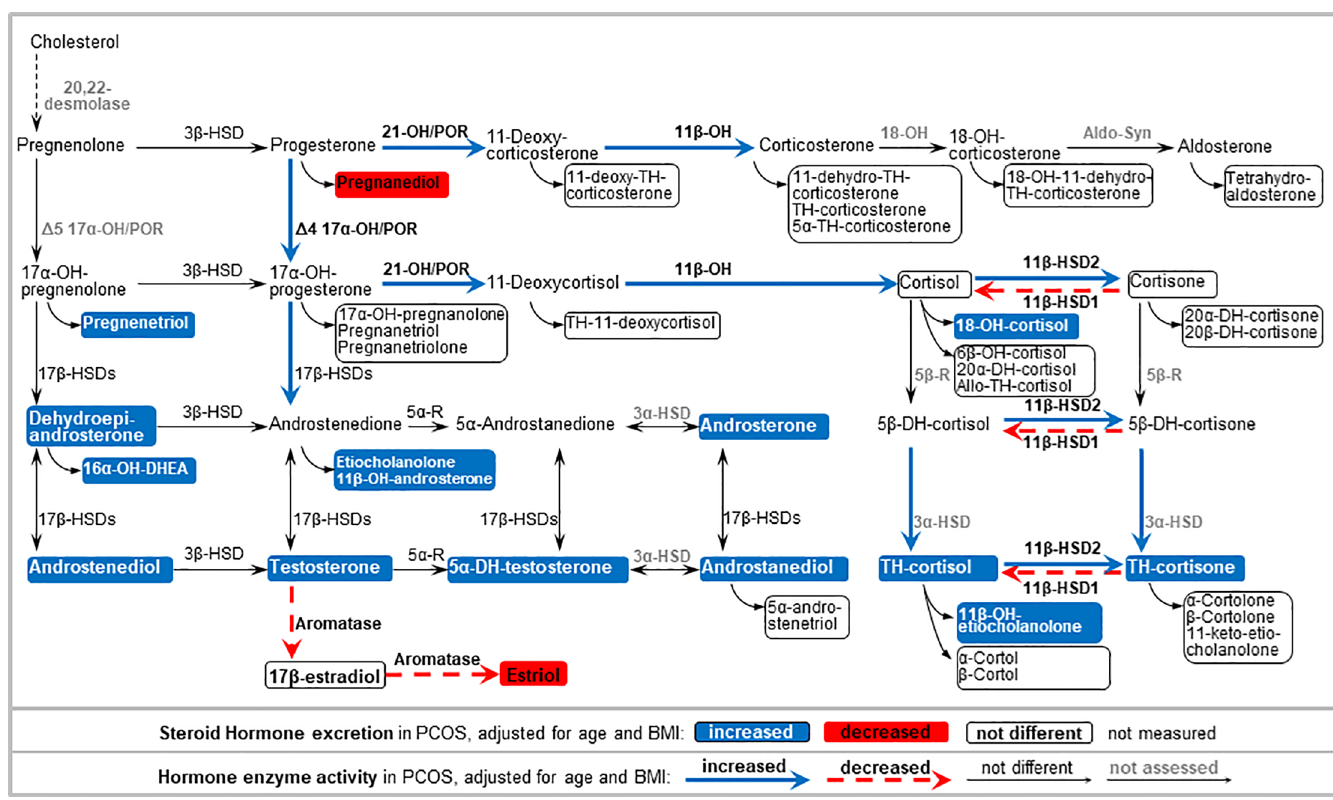
Fig 1. Scheme of alterations in 24-hour urine steroid excretion and steroid enzyme activities in PCOS compared to controls adjusted for age and BMI in multivariable analyses. Abbreviations: DHEA: dehydroepiandrosterone. An “OH” in enzyme names indicates a hydroxylase. An “OH” in steroid names indicates a hydroxyl group. DH: dehydro; TH: tetrahydro; HSD: hydroxysteroid dehydrogenase; POR: P450 oxidoreductase; Cyt b5: Cytochrome b5; 5 α -R: 5 α reductase; 5 β -R: 5 β reductase.